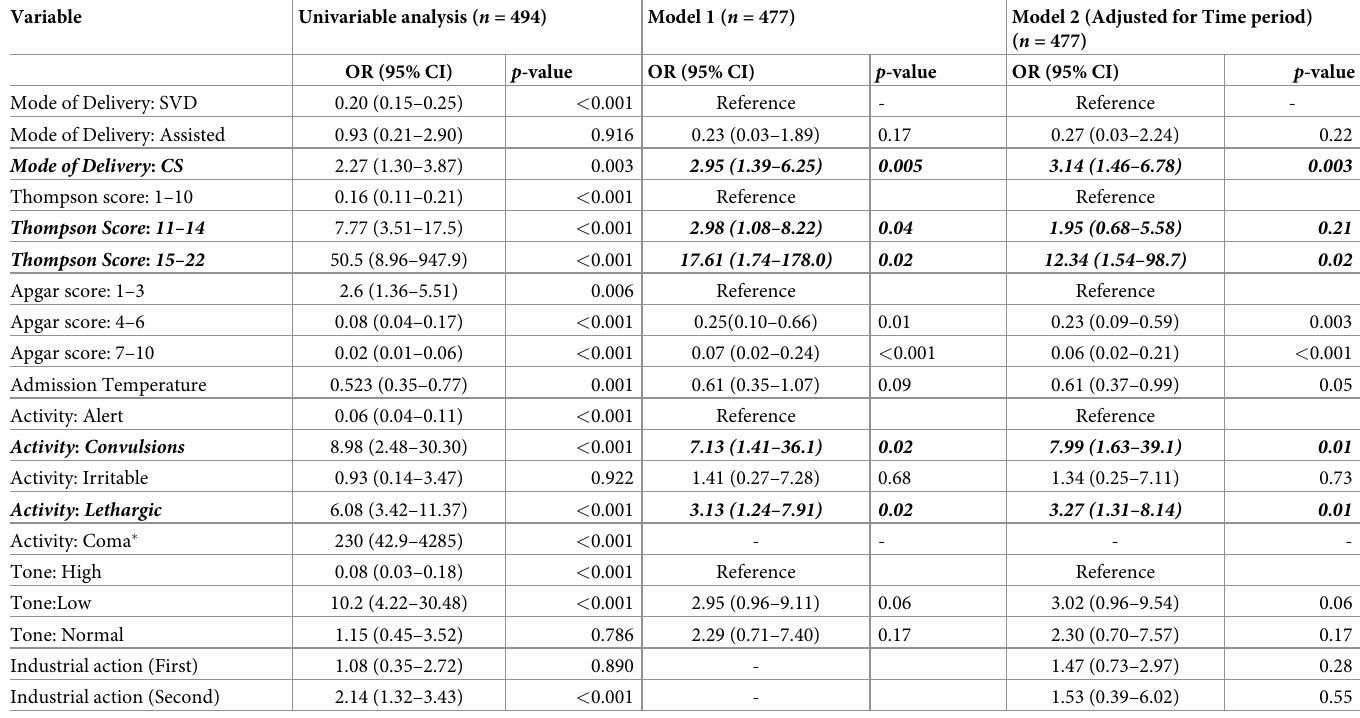
Table 2. Univariable ORs (95% confidence intervals) for risk factors and logistic regression models for neonatal mortality on imputed